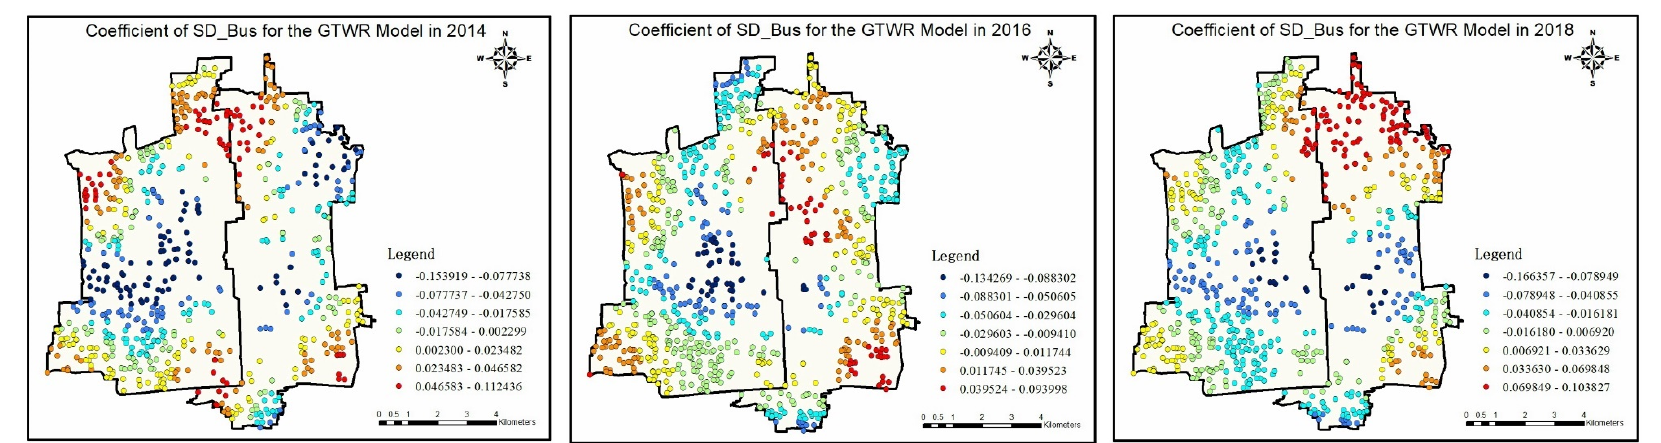
Figure 7. Coefficient of SD_Bus for the GTWR model in 2014, 2016, and 2018.